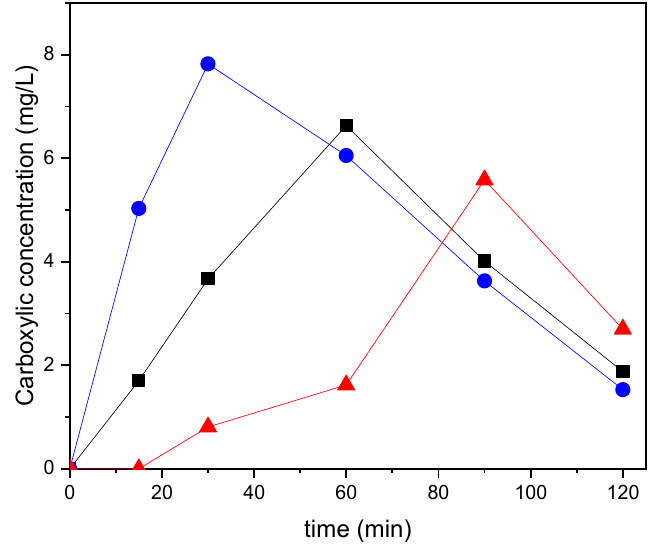
Figure 5. Carboxylic acids detected in the A-E-PMS treatment with high catalyst, where the blue line represents succinic acid, the black line corresponds to oxalic acid, and the red line, acetic acid. Fundamentally, three carboxylic acids were detected: oxalic, succinic, and acetic acid. These short chain acids reached their maximum concentration in treatment times of 30 min (succinic acid), 60 min (oxalic acid) and 90 min (acetic acid). The trend in these organic